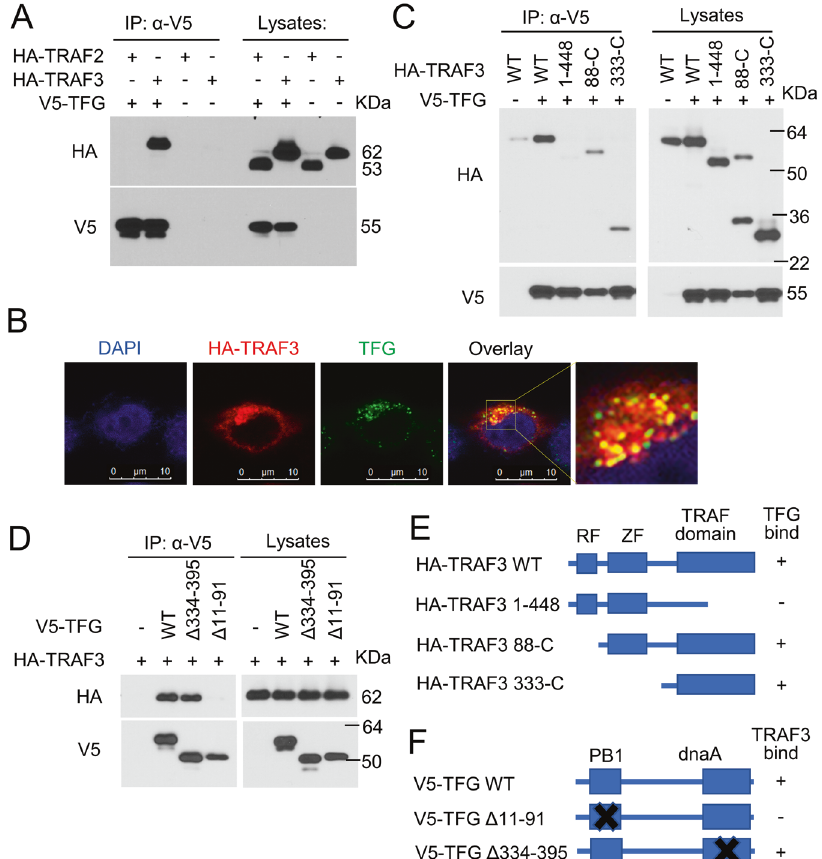
Fig. 4 PB1 domain of TFG and TRAF domain of TRAF3 mediates association of TRAF3 and TFG. A HEK293 cells were co-transfected with HA-TRAF2, HA-TRAF3, and V5-TFG. Co-IP assays were performed. TRAF2, another TRAF family member, served as a negative control. B HEK293 cells were transfected with HA-TRAF3. Colocalization of overexpressed HA-TRAF3 (red) and endogenous TFG (green) were analyzed by confocal microscopy. Nuclear was visualized by DAPI staining (blue). C V5-tagged TFG was transfected into HEK293 cells together with the indicated TRAF3 mutants. The physical interaction of TGF with the different TRAF3 mutants was determined by co-IP assays (left panel). The expression of TRAF3 mutants and TFG was monitored by direct IB using anti-HA and anti-V5 antibodies (right panel). D HA-tagged TRAF3 was transfected into HEK293 cells together with the indicated TFG mutants. The physical interaction of TFG with the different TRAF3 mutants was determined by co-IP assays. E, F Schematic diagram of wild-type (WT) form and deletion mutants of TRAF3 ( E ) and TFG ( F ). Their TFG ( E ) and TRAF3 ( F ) binding ability ( + ) or de fi ciency ( − ) is summarized based on the results presented in C and D . RF RING fi nger, ZF TRAF-type zinc fi nger, PB1 PB1_TFG domain, dnaA dnaA domain. Experiments were independently repeated three